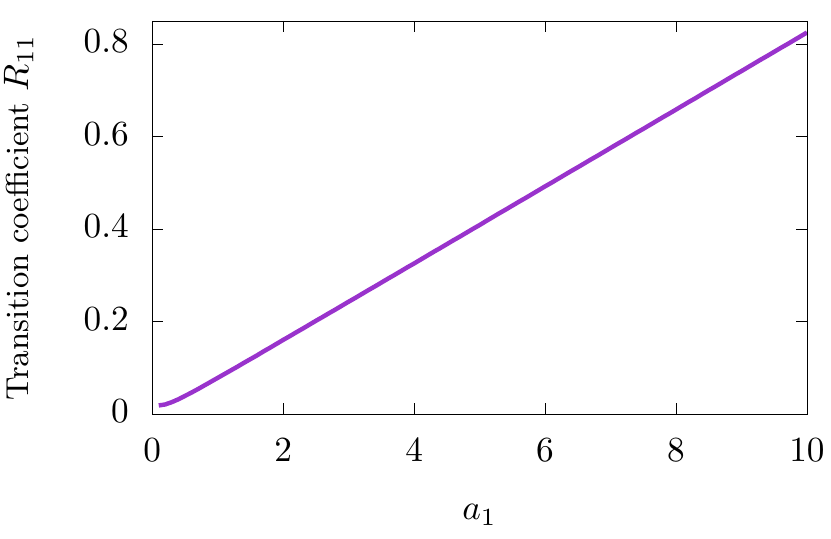
Figure 21 . The response function R 11 (∆ E ) , plotted with respect to varying a 1 for accelerated atoms in thermal background considering the Rindler modes in (1 + 3)